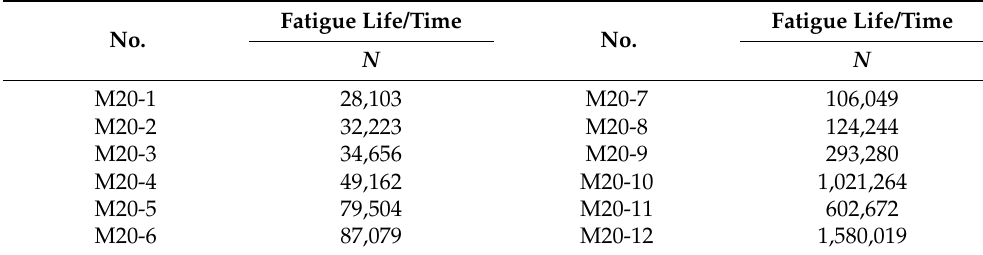
Table 15. Constant amplitude fatigue life of M20 bolts under full pretension force. No.